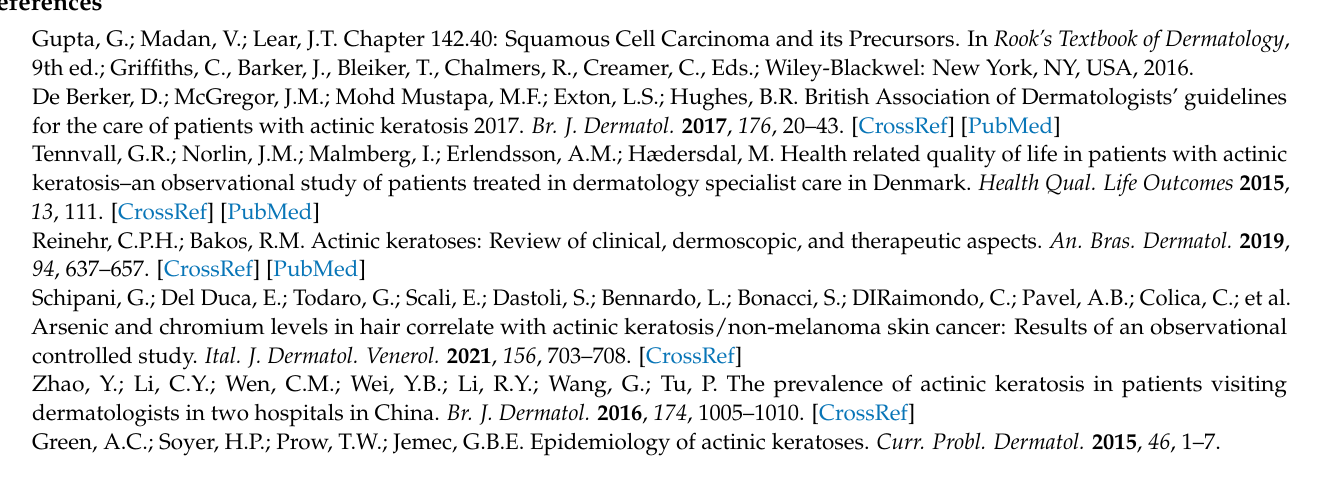
tion dimensions. Table S2: Treatment perception dimensions. Table S3: Treatment concerns according to gender. Table S4: Prioritization of causal attributions. Table S5: Causal attributions according to gender n (%). Table S6: Causal attributions according to educational level n (%). Table S7: Causal attri- butions according to skin cancer history n (%). Table S8: Statistically significant correlations. Table S9: Statistically significant correlations of knowledge of the term AK. Table S10: Statistically significant correlations of readiness for treatment, if positive in one of the two questions of information